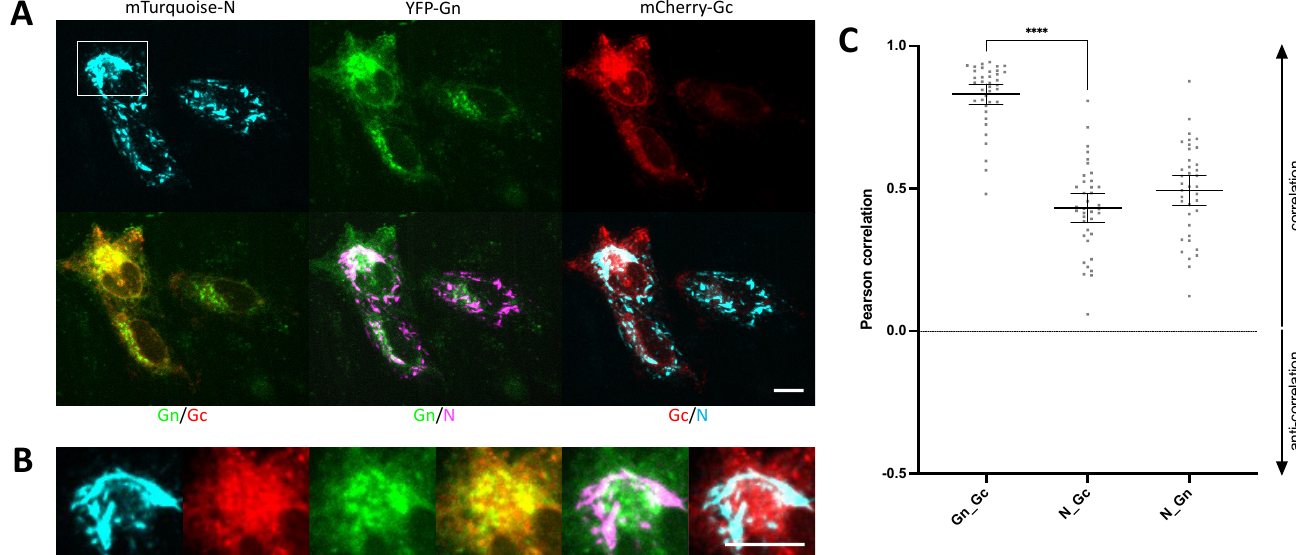
Figure 5. mTurquoise-N co-localizes with fluorescently tagged Gc and Gn. ( A ) CHO-K1 cells were transfected with mTurquoise-N (shown in cyan), YFP-Gn (green), and mCherry-Gc (red) and imaged 24–48 h p.t. ( B ) Magnification of the boxed region shown in ( A ). Co-localization in overlay images appears orange (green and red), white (green and magenta, or red and cyan). Scale bars: 10 µ m. Additional examples can be found in the SI. ( C ) Pearson correlation between proteins as stated in the bar chart were assessed by automated image analysis as described in Figure 4. All bars show mean with Figure 6 SEM ( n = 38). Significance was tested using a one-way analysis of variance (ANOVA) **** p ≤ 0.0001.